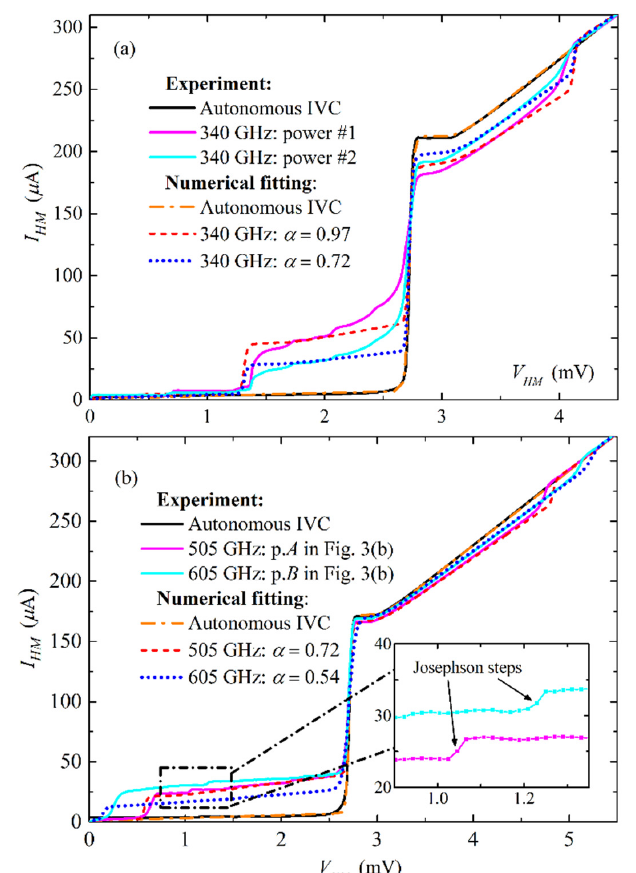
Figure 5. Autonomous and pumped HM IV-curves, experimental (solid) and numerical (dashed and dotted) curves for different experimental samples: ( a ) Sample designed for 250–450 GHz, two pumping powers at 340 GHz are presented from the experiment and simulated with α = 0.97 and α = 0.72; ( b ) Sample designed for 400–700 GHz, two pumping powers at 505 GHz and 605 GHz are presented from the experiment and simulated with α = 0.72 and α = 0.54, respectively.